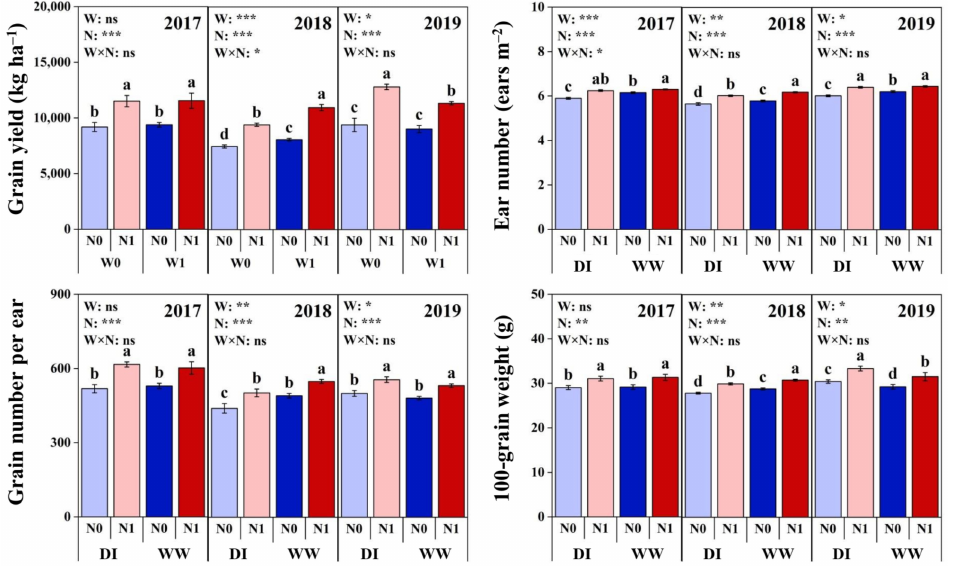
Figure 3. Effects of nitrogen fertilization (N) and seedling-stage water management regime (W) on maize grain yield and yield components at maturity in 2017–2019. Note: *, ** and *** indicate significance at p < 0.05, p < 0.01 and p < 0.001, respectively, and ns indicates non-significance ( p > 0.05). Different letters above bars indicate significant differences between treatments ( p <